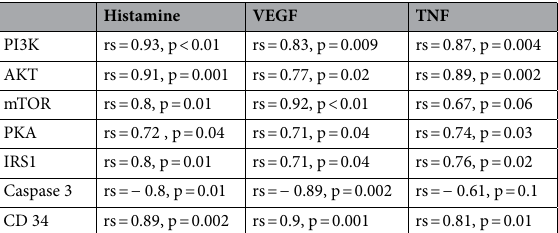
Histamine VEGF TNF PI3K rs = 0.93, p <